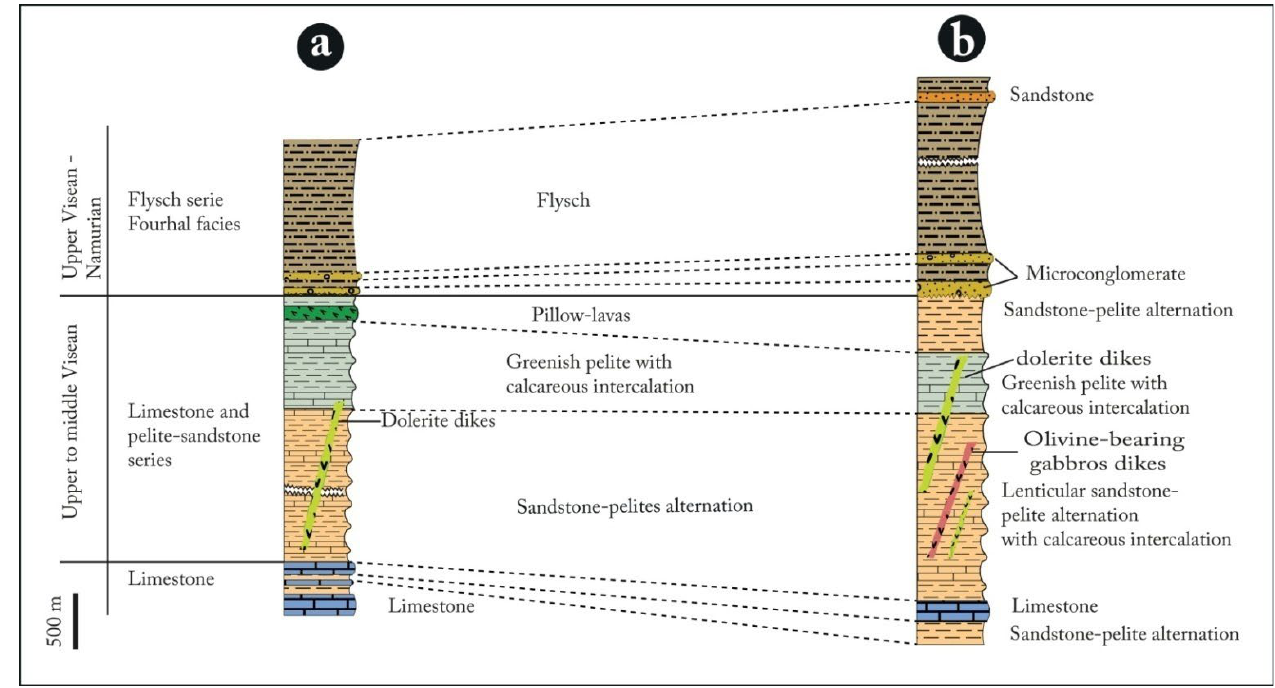
Figure 5. Correlation betweensynthetic lithostratigraphic logs of the southern ( a ) andnorthern ( b ) sectors of study area.